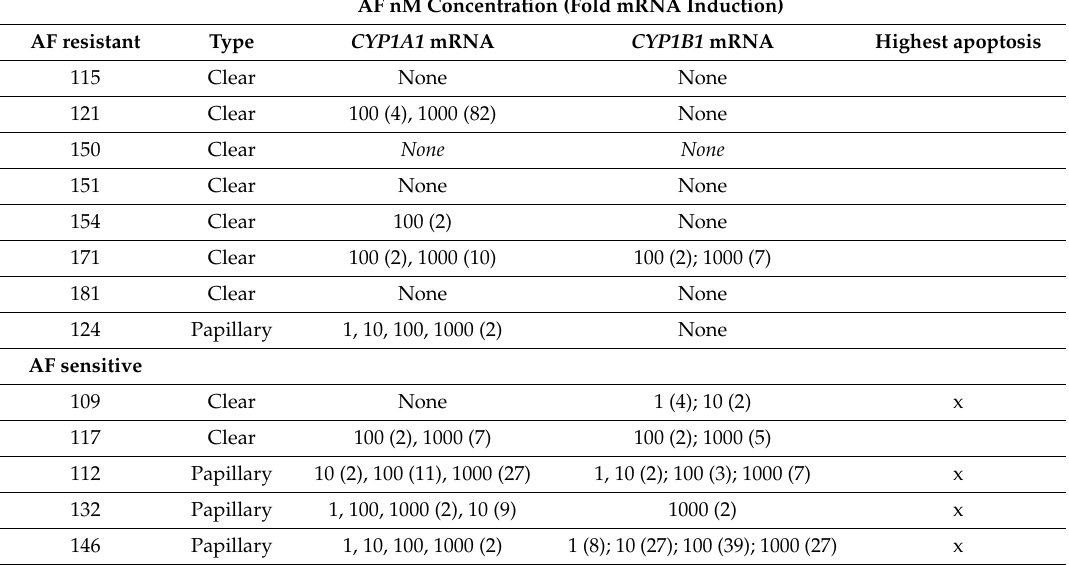
Table 1. Renal cell strains were exposed to 0, 1, 10, 100 and 1000 nM AF for 24 h in Dulbecco’s modified Eagle’s medium containing 4.5 gm / L D-glucose supplemented with 5% fetal calf serum. Cells were processed, and CYP1A1 and CYP1B1 mRNA was quantitated by RT-PCR. Fold CYP1A1 or CYP1B1 mRNA induction relative to the untreated controls is indicated regarding the AF concentration for which induction was observed. Cells with high apoptosis are shown (data reported in